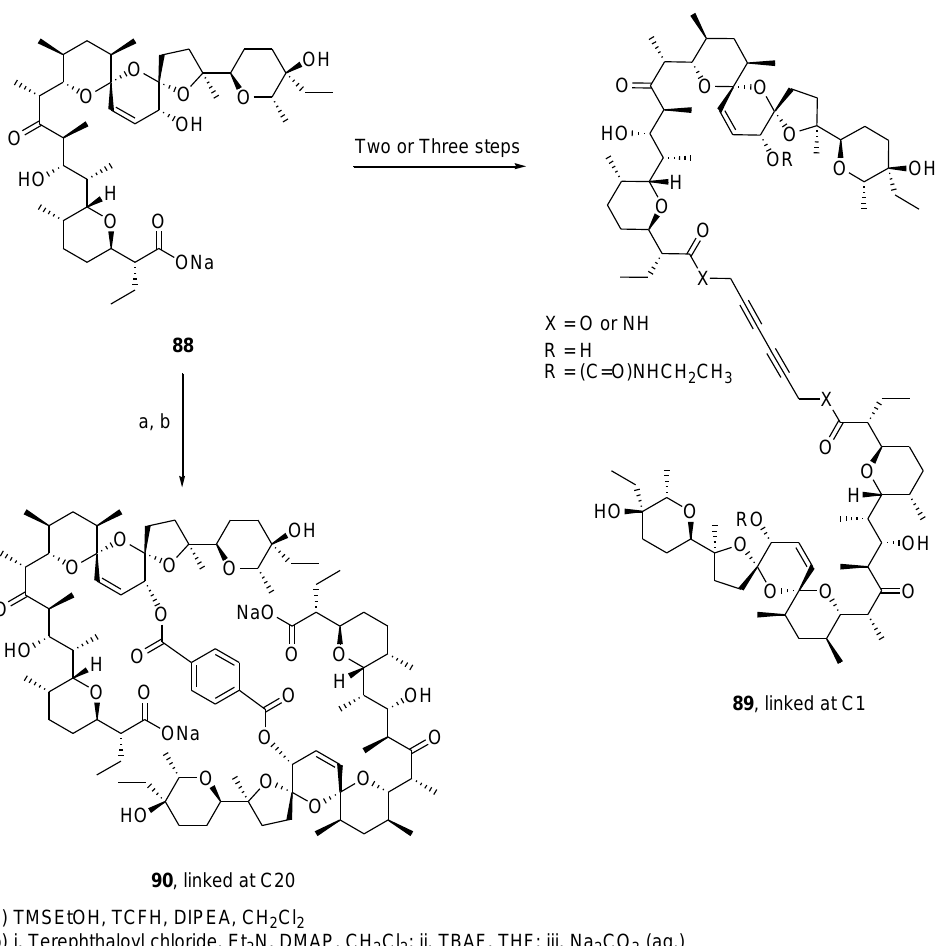
Figure 18. Synthesis of C2- symmetric salinomycin dimers 89 linked at C-1 and 90 linked at C-20 by a diyne chain and a terephthalate ester, respectively.